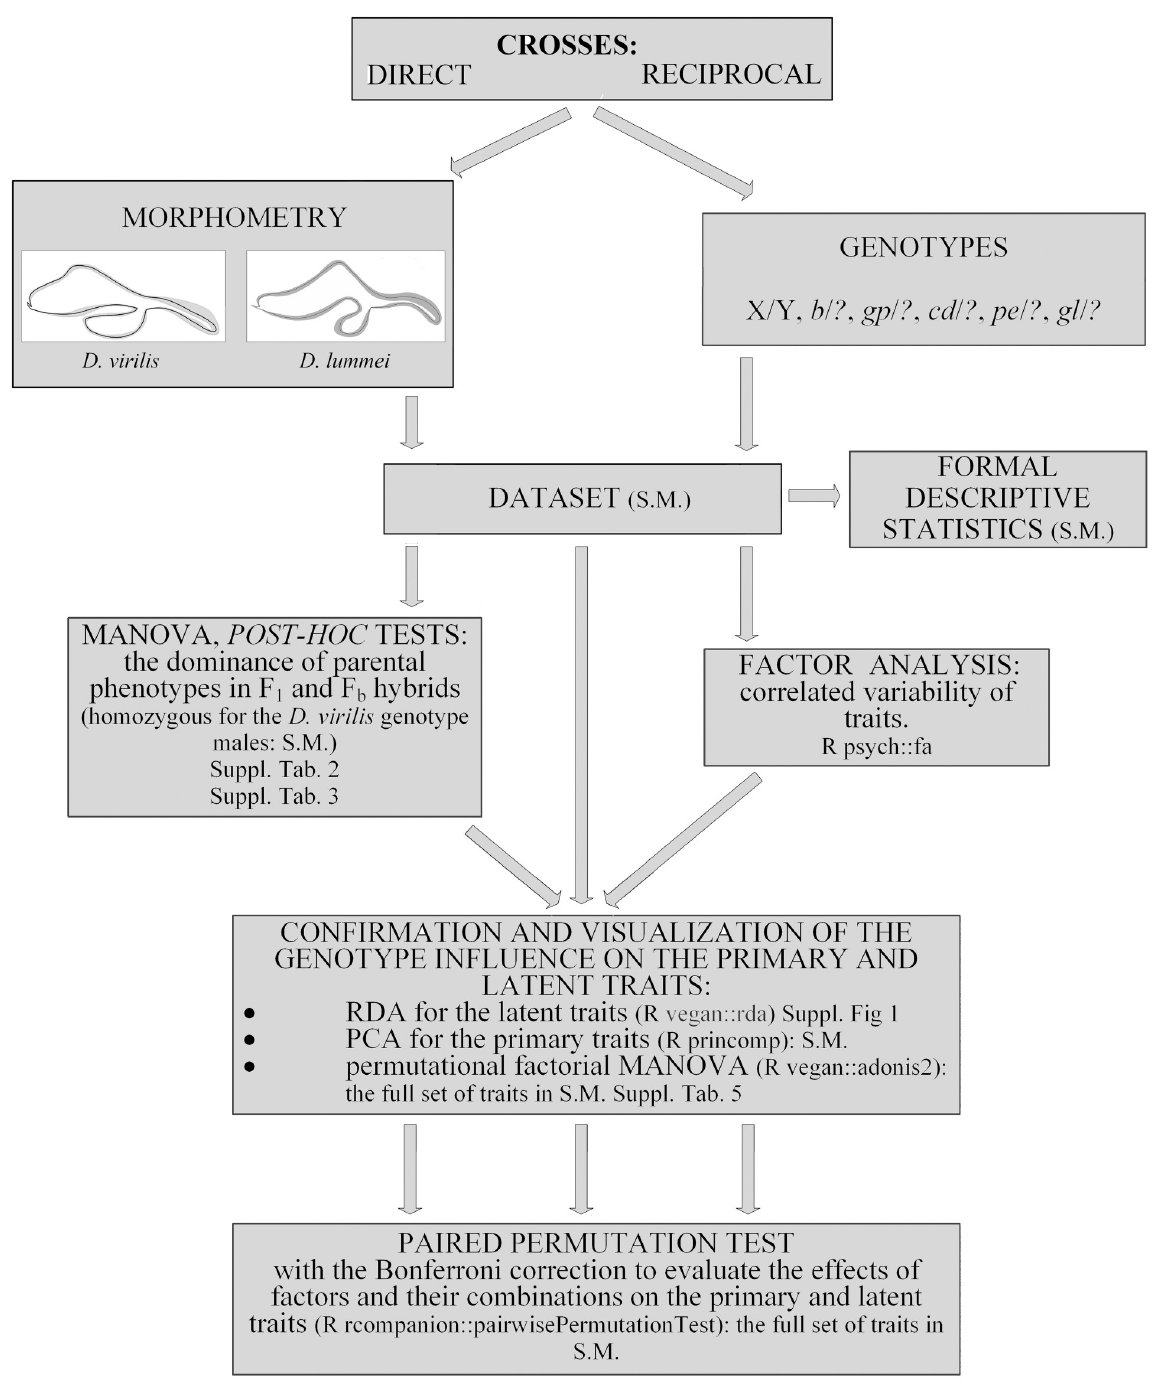
Fig 3. The pipeline of all analyses in the study. S.M.: the raw data or the results of the particular analysis are presented in Supplementary Material.